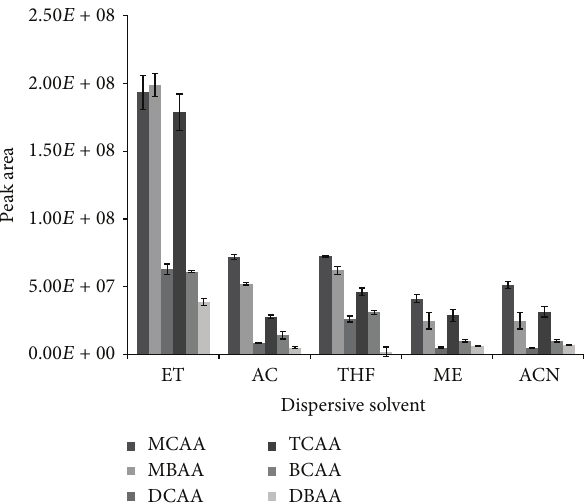
Figure 4: Effect of type of dispersive solvent on the simultane- ous dispersive liquid-liquid microextraction and derivatization of 0.5 𝜇 gL −1 haloacetic acids at experimental conditions of 10min reaction time, 25 ∘ C temperature, 30 𝜇 L TFAA as catalyst, and 1mL n -octanol as both extractant solvent and derivatization